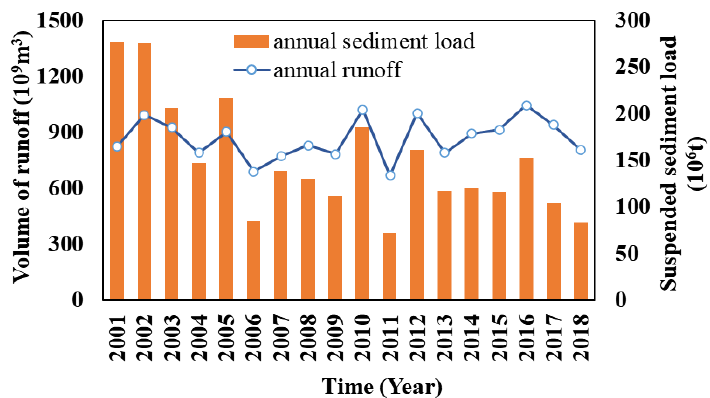
Figure 10. Annual runo ff and suspended sediment load recorded at the hydrometric station of Datong.